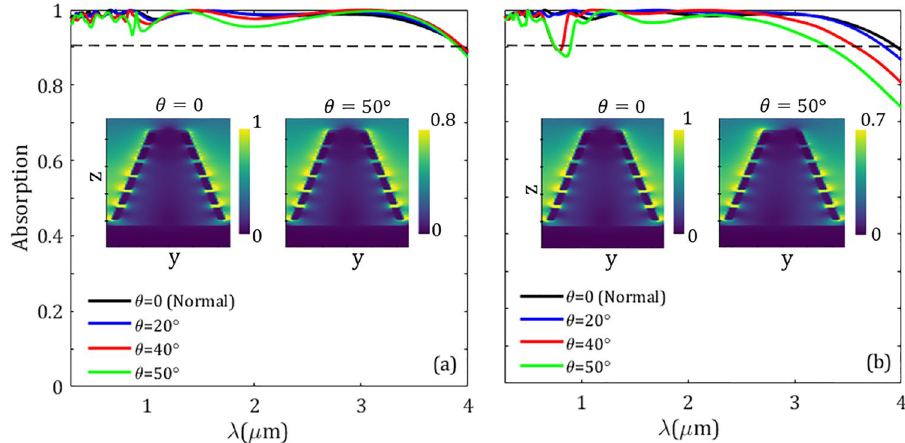
Figure 10. Absorption spectra for different incident angles. ( a ) TE polarization and ( b ) TM polarization. In the inset, the magnitude of the electric field | E | is displayed in the yz -plane for normal and oblique incidence at wavelength (cid:31) = 4 µ m . Note that the electric field of the launching beam is always in the yz -plane for both polarizations.